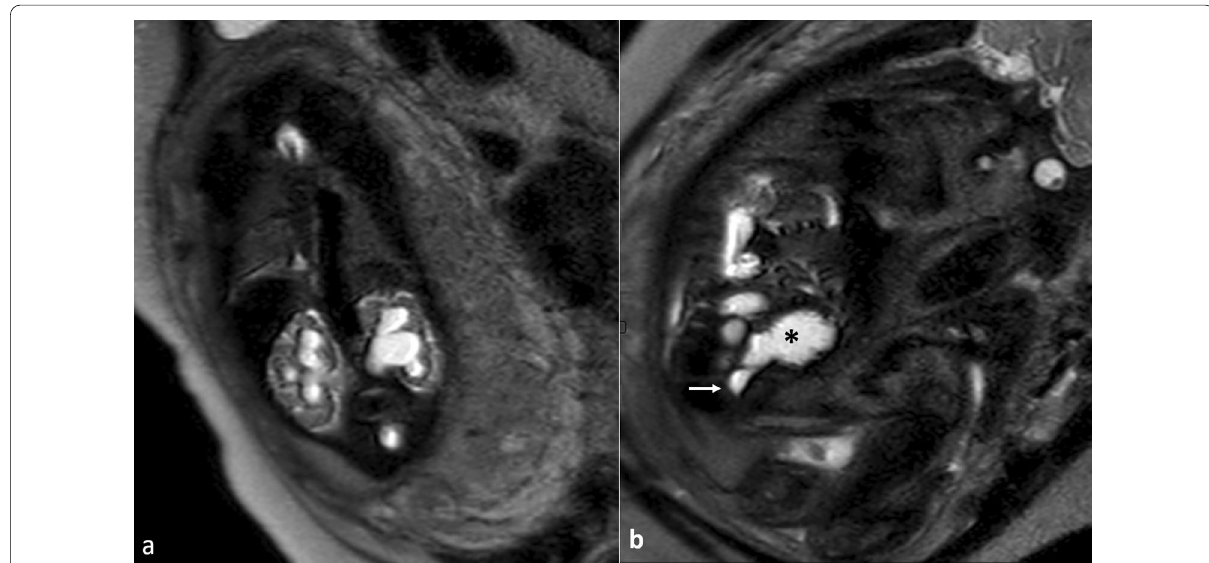
Fig. 9 28-week fetus with urinary tract dilatation (A2-3) associating posterior urethral valve. a Coronal BFFE reveals thinning of the renal parenchyma, poor corticomedullary differentiation, tiny renal cortical cysts. b sagittal BFFE reveals thick trabeculated urinary bladder wall (asterisk) with dilated posterior urethra (arrow). Oligohydramnios is also seen